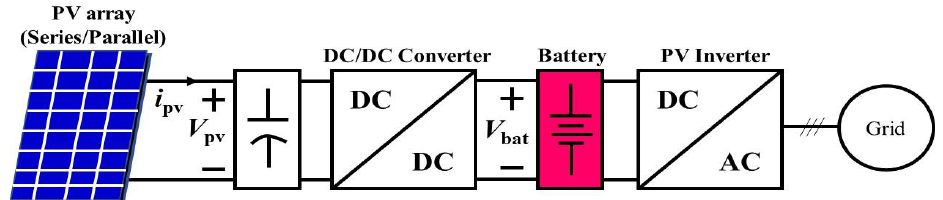
Figure 1. Configuration diagram of a typical PV system with two stages (DC-DC converter and DC-AC inverter).